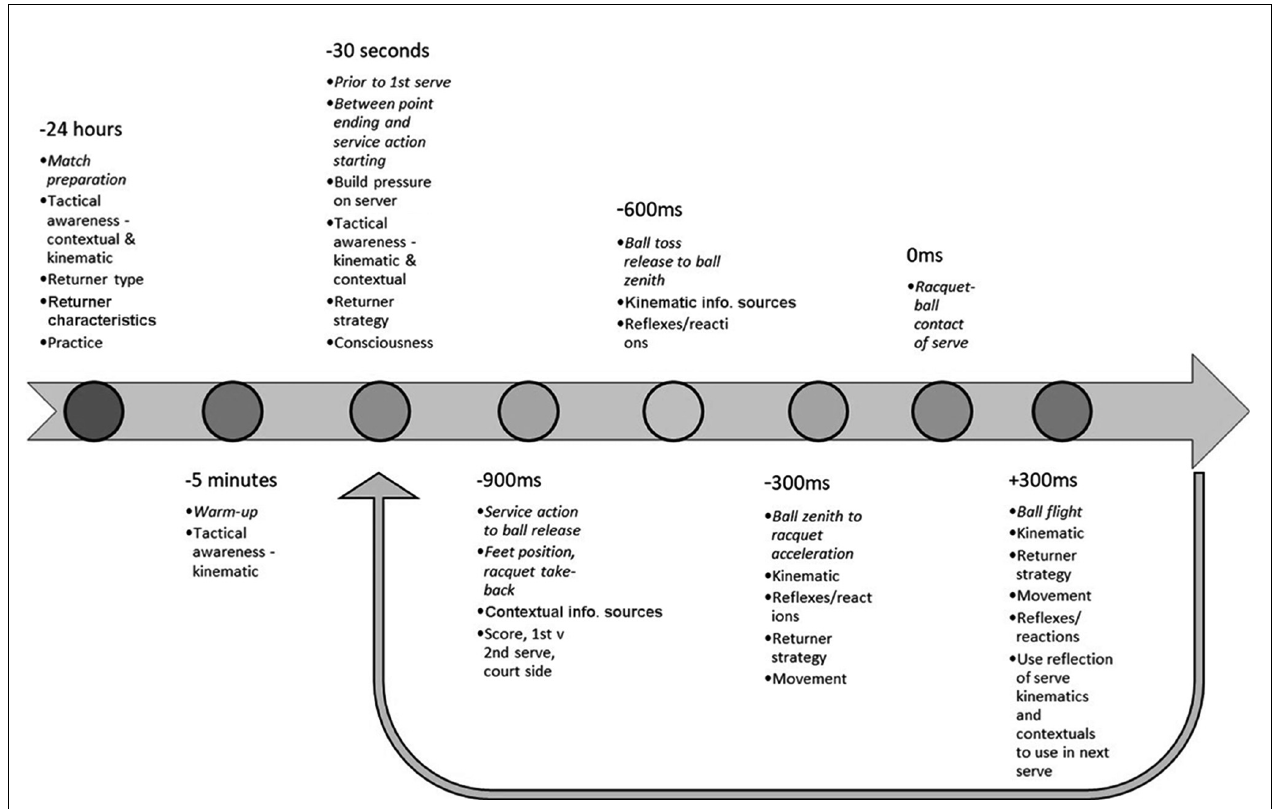
FIGURE 1 | Temporal model depicting the use of anticipatory information sources during the return of